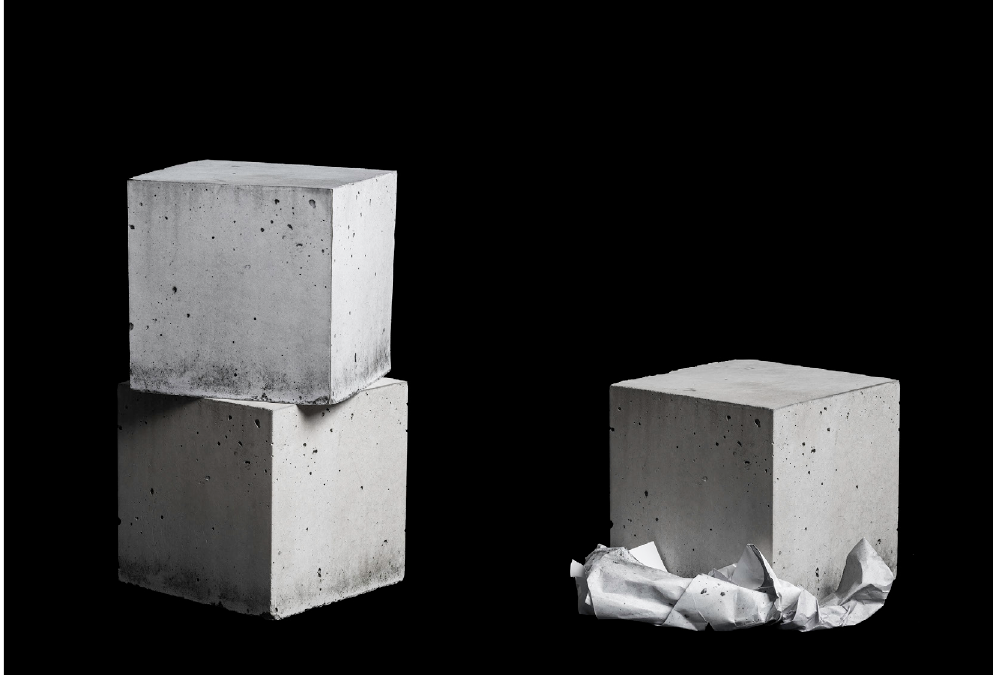
Fig. 6a, 6b Kambiz Shafei, Concrete Blocks , 2019, Photography, laser print, and concrete. Basel,